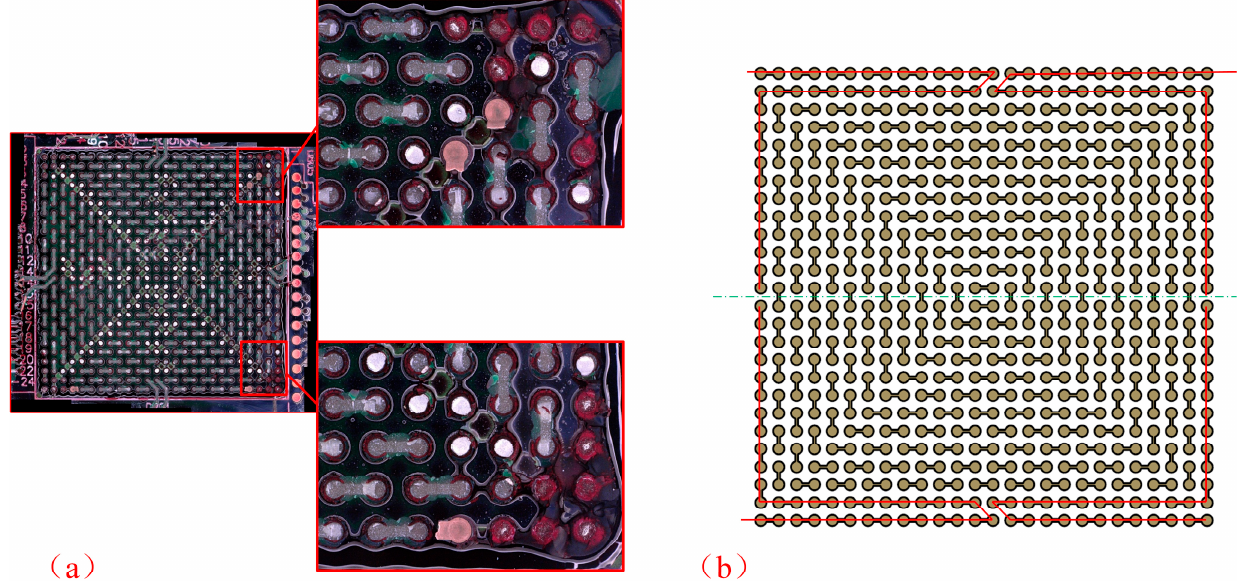
Figure 10. The temperature cycling tests results in D101: ( a ) dye and pry test results, ( b ) typical solder joint failure locations.